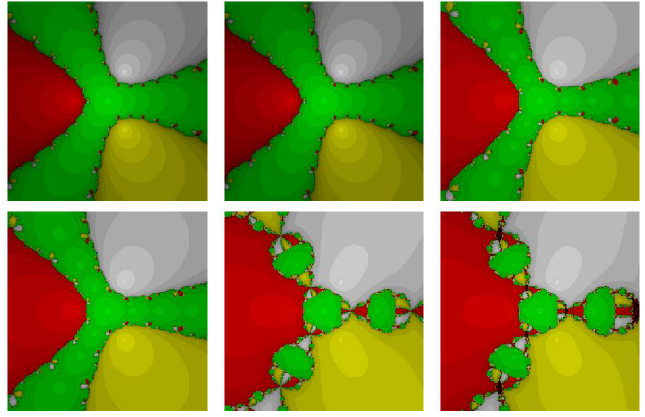
Figure 3. The basins of attraction for RM 2 , MRM 2 , HM 3 , MHM 3 , SM 3 and MSM 3 , from left to right and top to bottom, respectively in Problem 2.